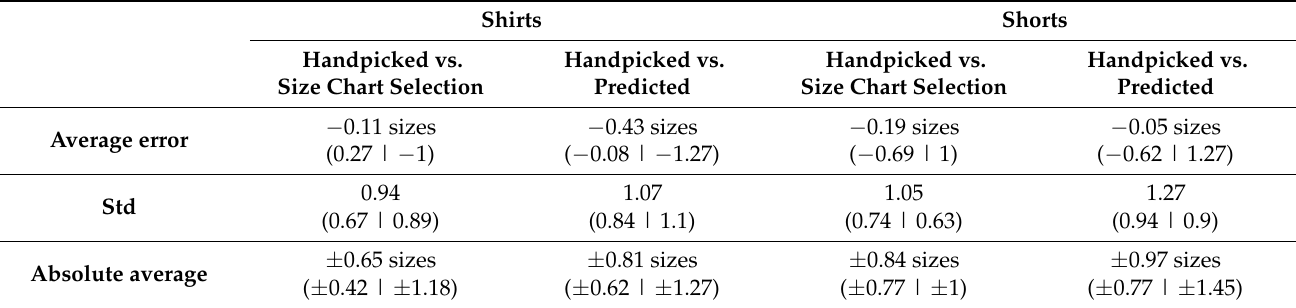
both shirts and shorts.